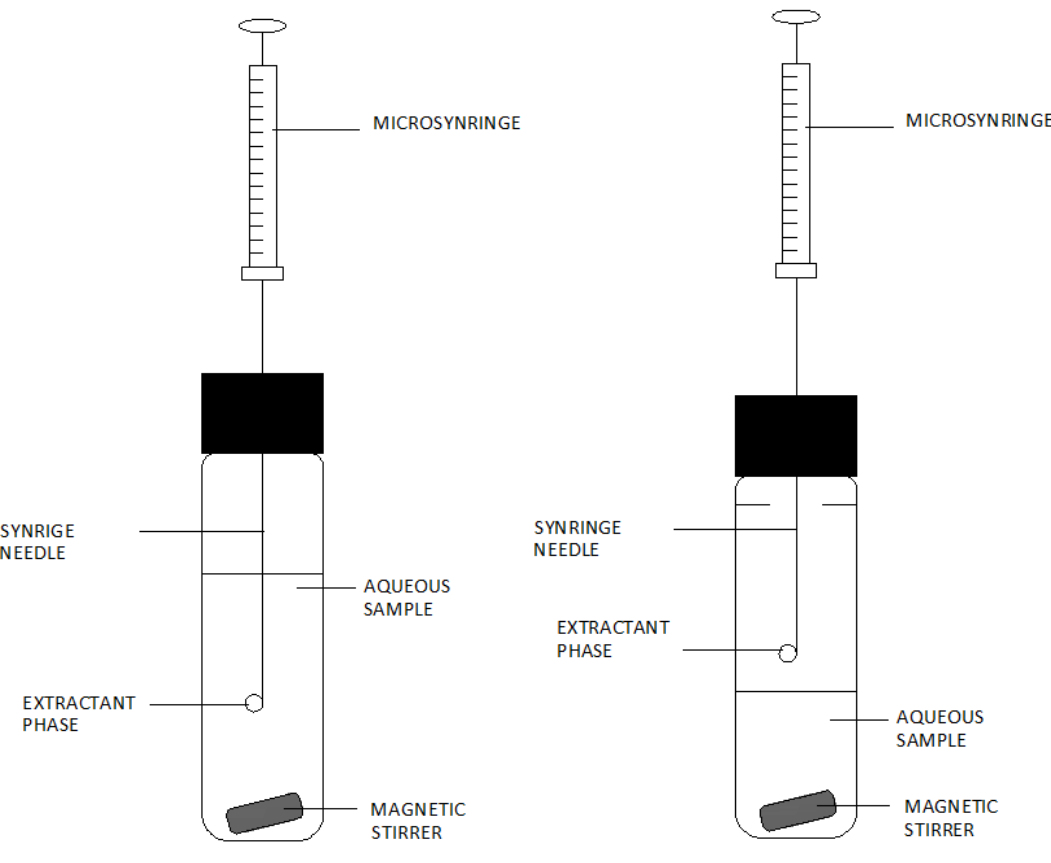
Figure 3. Diagram of a set for direct immersion single-drop microextraction